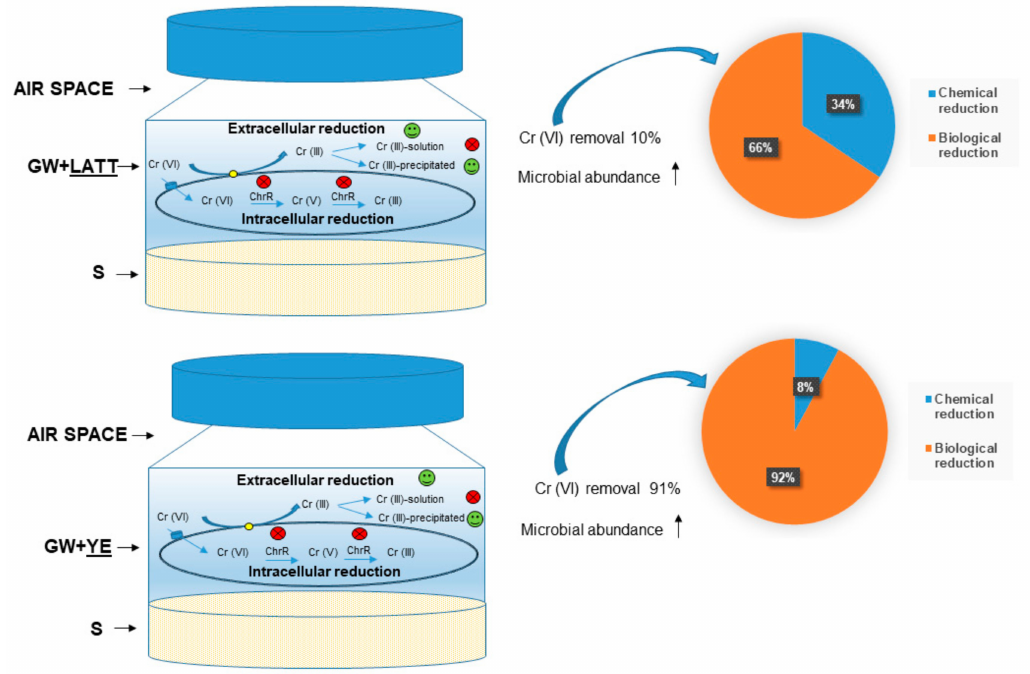
Figure 8. Scheme of the probable mechanisms of Cr (VI) reduction occurred after four days of incubation in the LATT and YE laboratory microcosms. GW—groundwater;